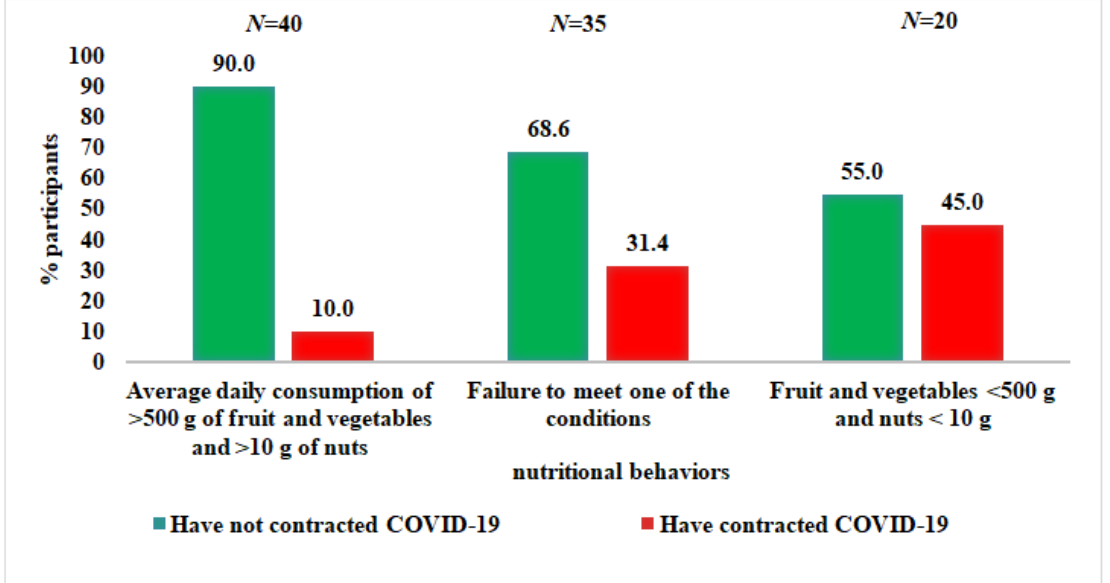
Figure 5. Associations between the consumption of vegetables, fruits, and nuts and the incidence of COVID-19.